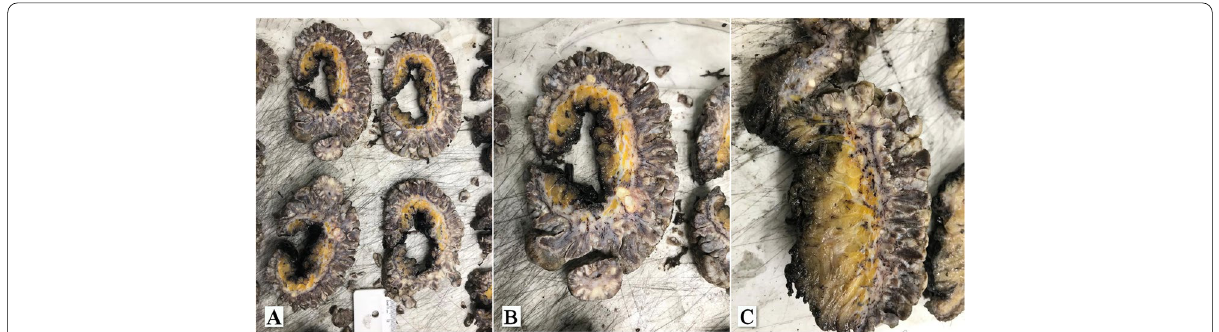
Fig. 2 Cut surface of the